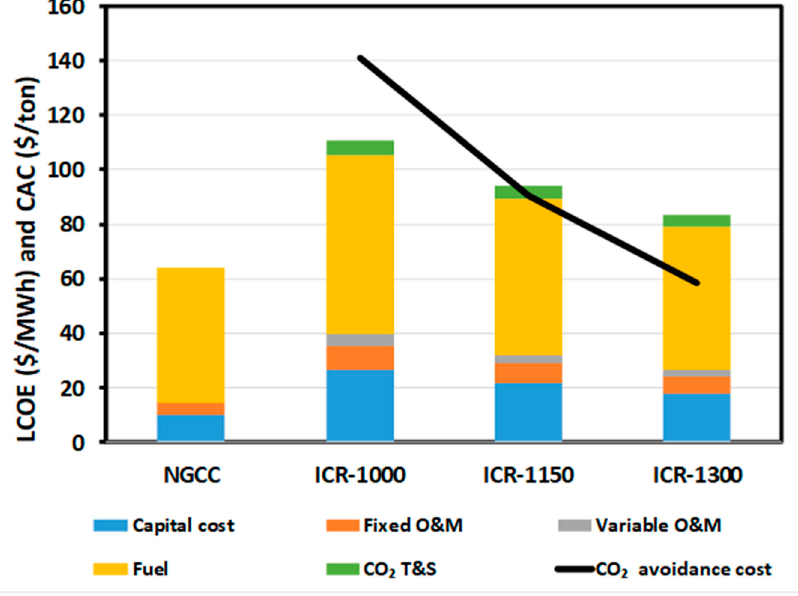
Figure 12. Levelized cost of electricity (LCOE) and CO 2 avoidance costs (CAC).